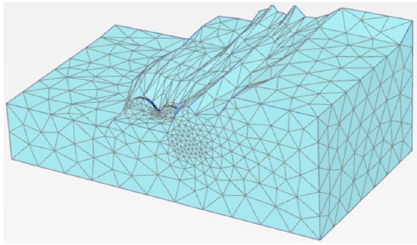
Figure 9. Model grids for the triple adjacent tunnels.